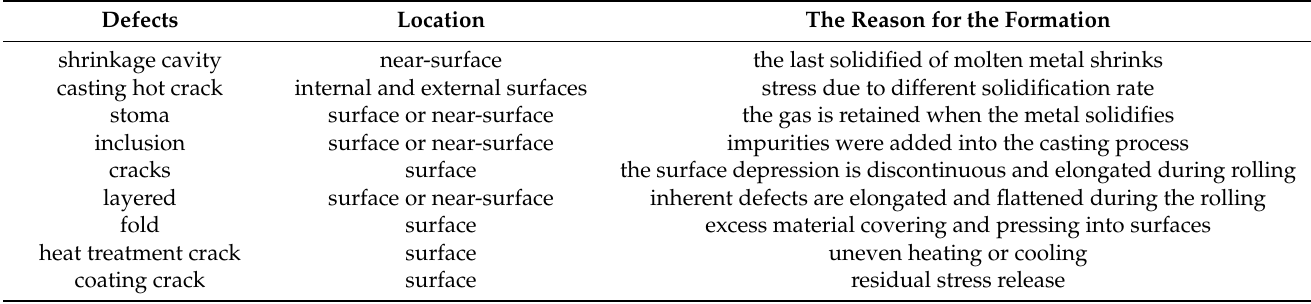
Table 1. Defects of steel pipelines produced during prefabrication and their causes [4,5,7–9,26,27]. Defects